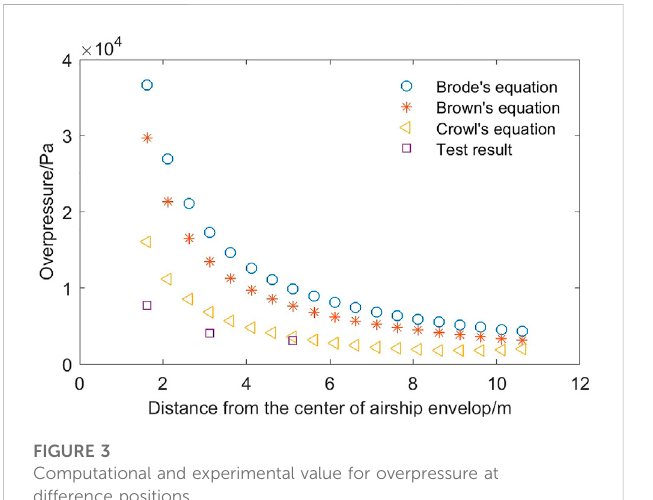
FIGURE 3 Computational and experimental value for overpressure at difference positions.